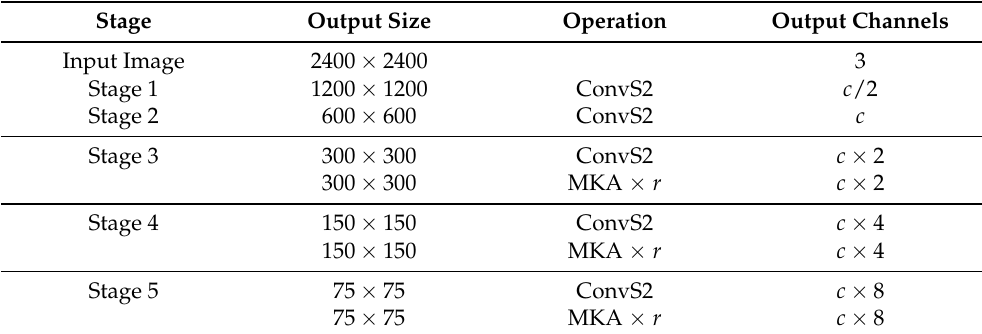
Table 1. Encoder